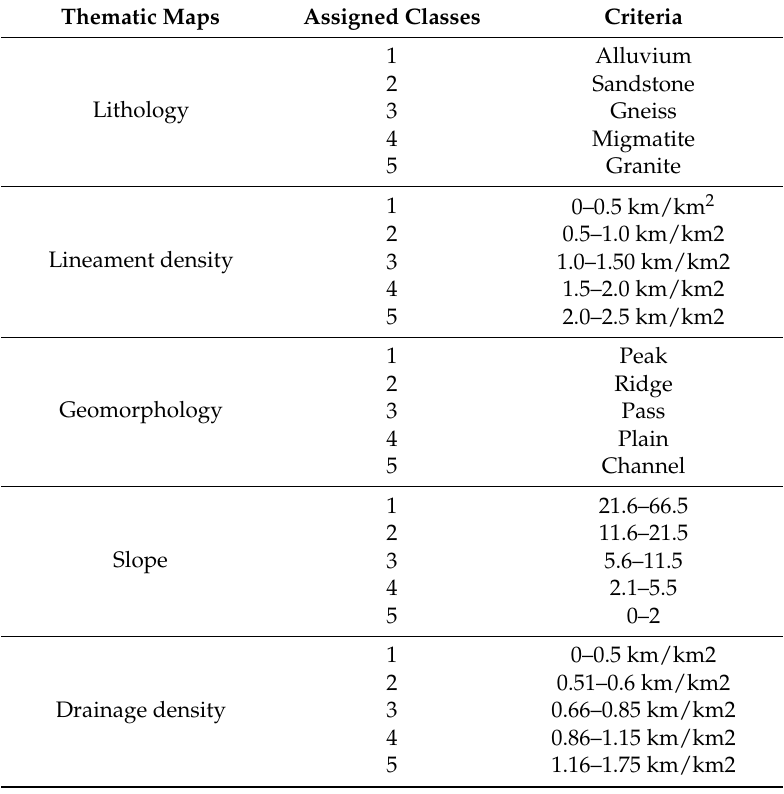
Table 2. Assigned classes of the features of the thematic maps used to model groundwater potentials in the study area using ArcGIS weighted overlay